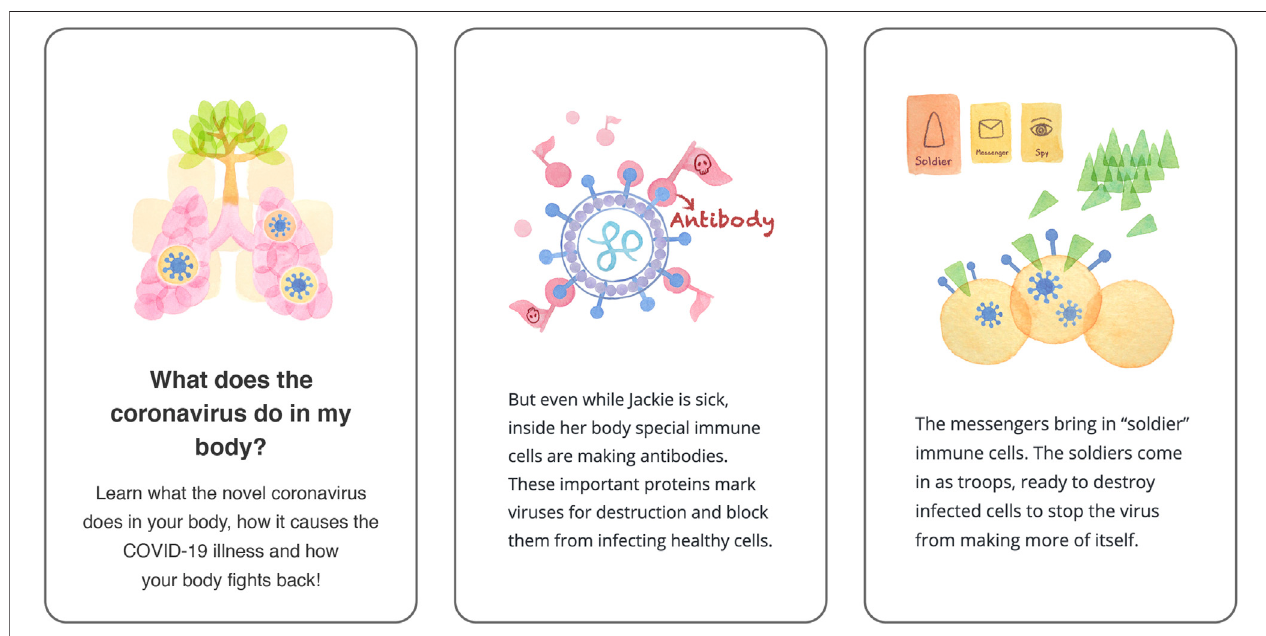
FIGURE2| Abovewe ’ vereproducedthreeofthe “ cards ” containedwithintheCOVID-19Mechanismcourse,astheywouldbeseenonamobiledevice.The fi rstis the title card of the course, while the others are example cards to demonstrate the visual style, informational content, and amount of text.